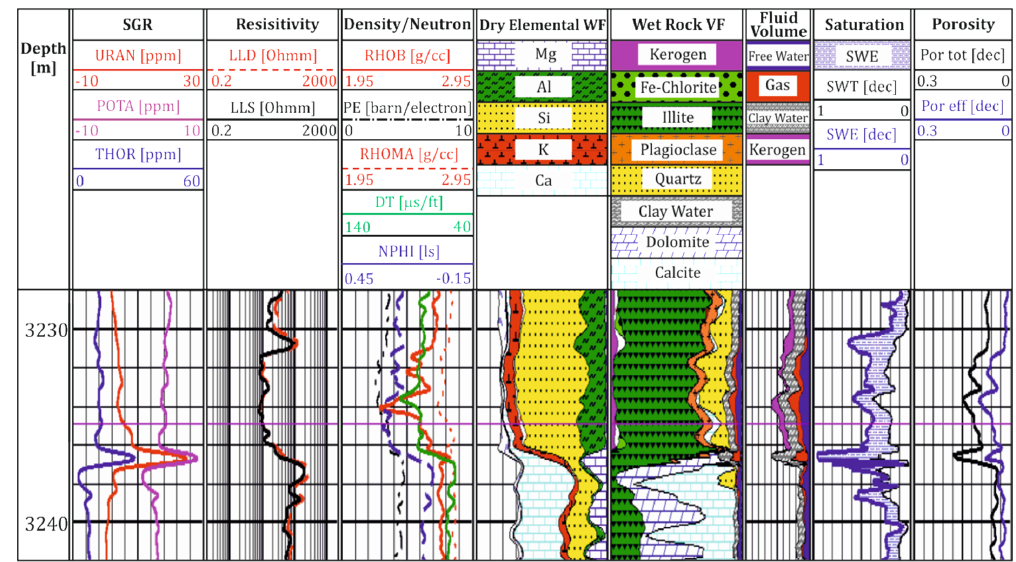
Figure 5. Results of the standard well logging (SGR, resistivity, density / neutron tracks), geochemical measurement and interpretation (dry elemental WF, wet rock VF track), interpreted fluid type, saturation and porosity values (fluid volume, saturation, porosity track); Well-1, depth interval 3218–3242 m. Two basic datasets were considered for the analysis of the laboratory measurement results (Tables 2 and